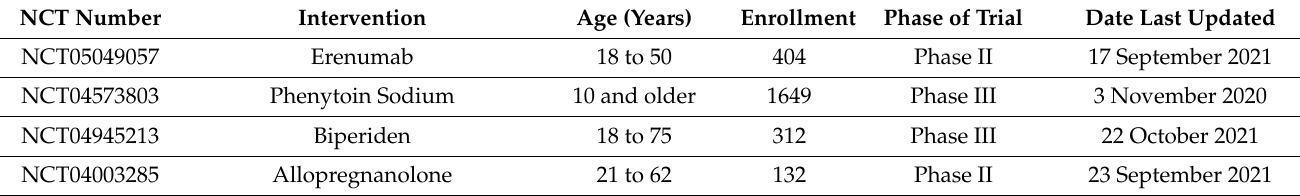
Table 4. Studies active but not recruiting (as of 3 December